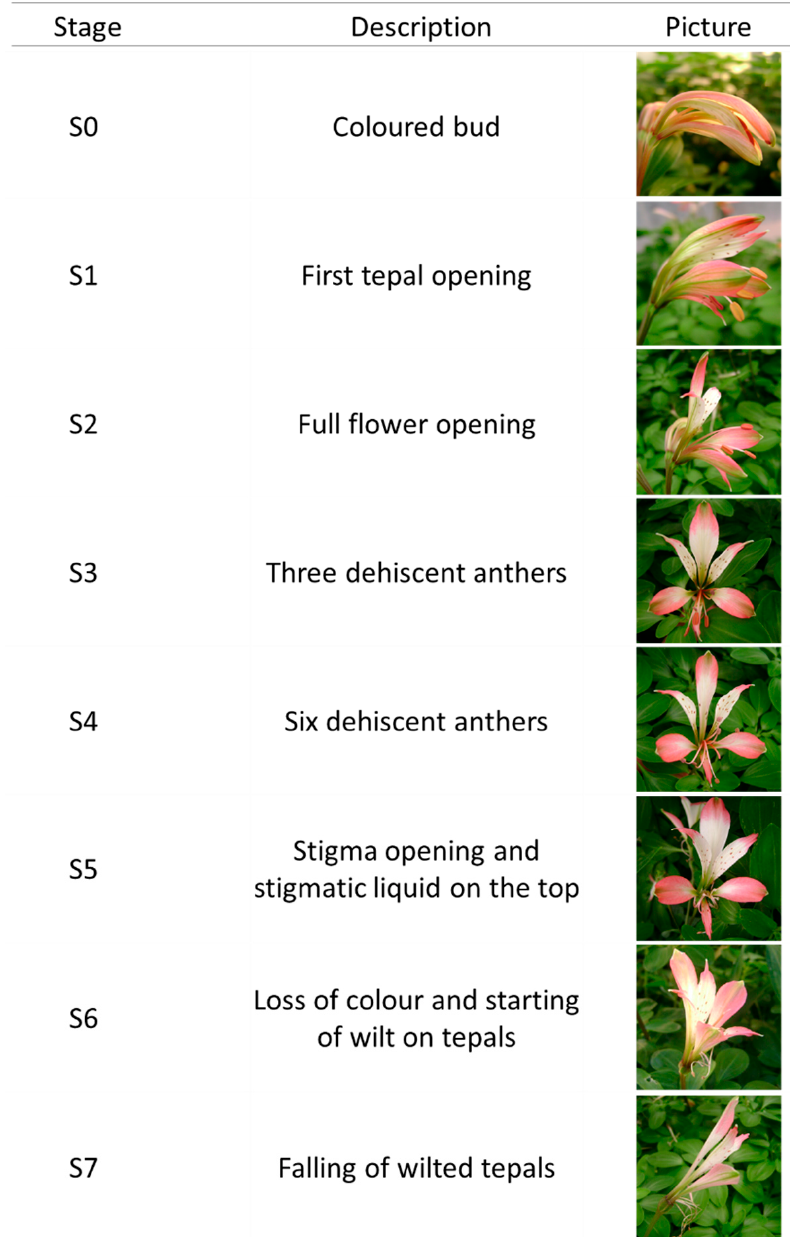
Figure A1. Description of the stages of development observed in alstroemeria, from stage 0 (S0) to 7 (S7) according to Wagstaff et al. (2001). Pictures provided correspond to A. caryophyllaea Jacq.